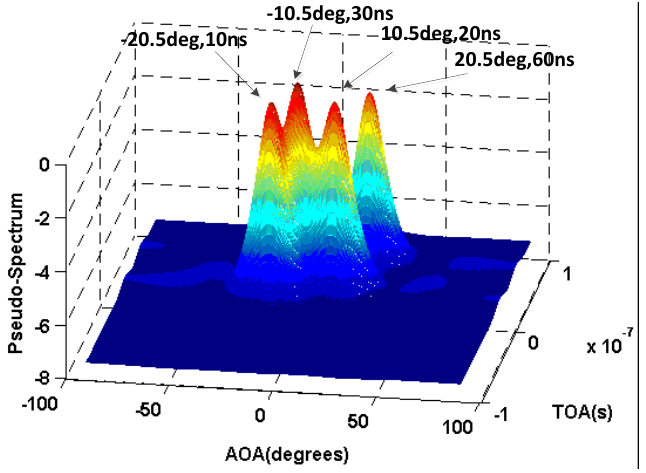
Figure 5. Result of AOA and TOA estimation for the incoherent